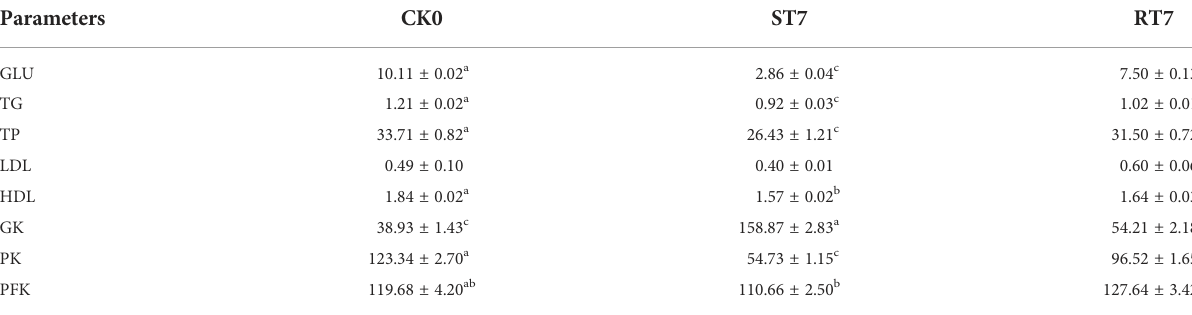
TABLE 1 Effects of starvation and refeeding on serum biochemical indices and glycolysis-related enzymes in golden pompano.